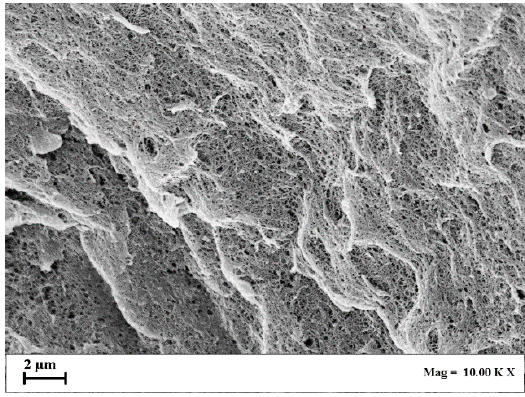
Figure 4. SEM image of the aerogel surface at 8 wt% agarose.